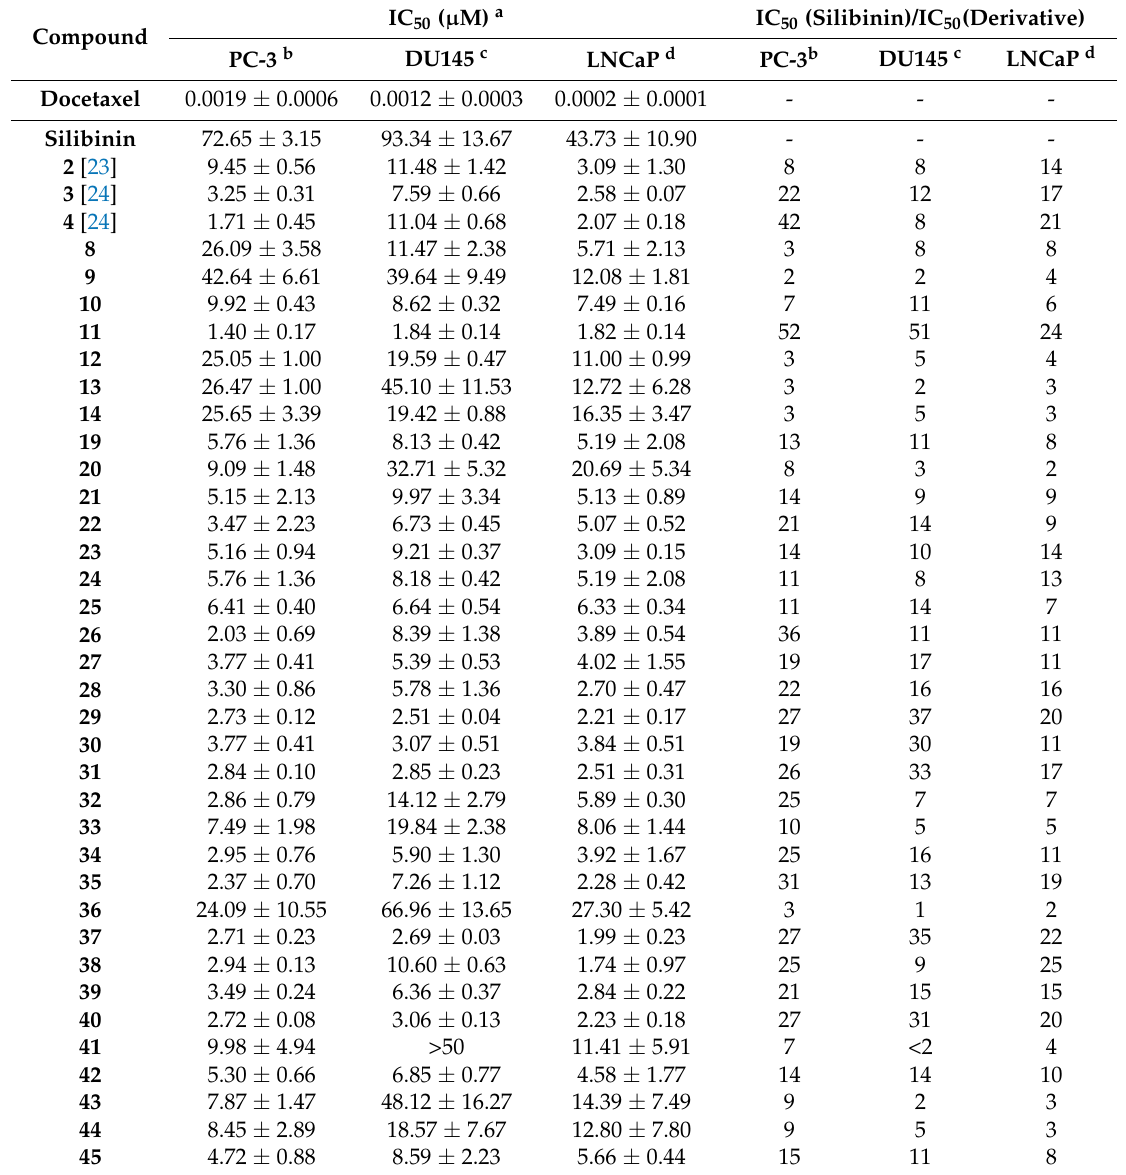
Table 1. Anti-proliferative activity of